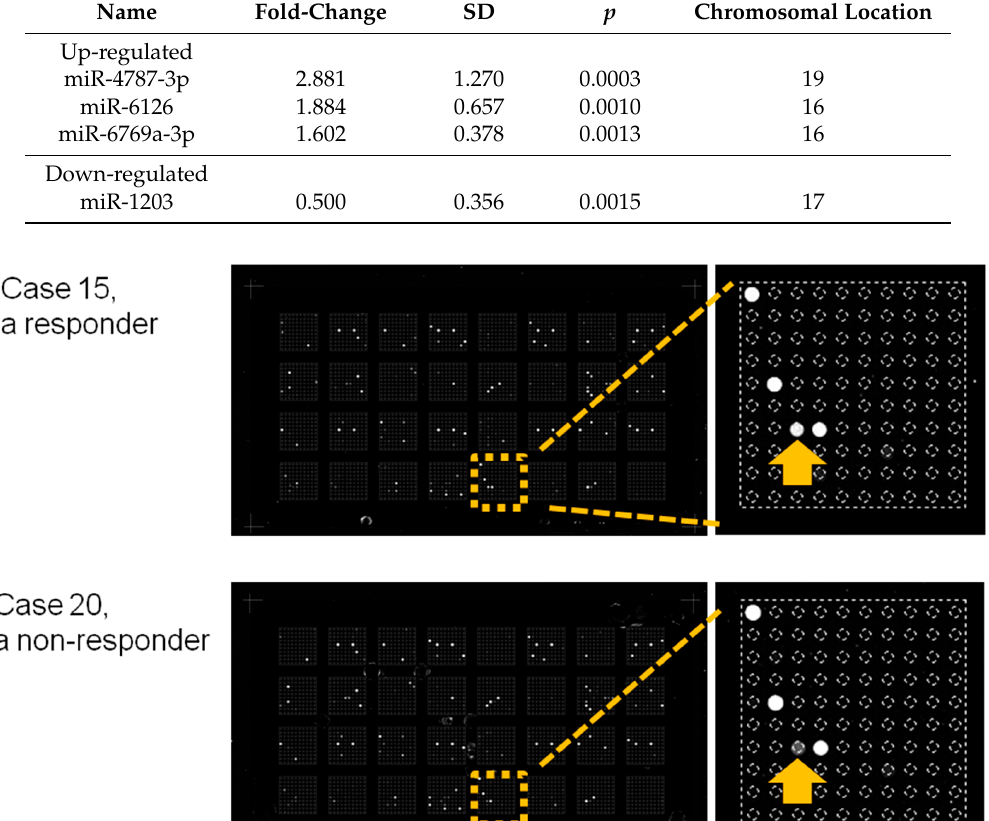
Table 2. Serum miRNAs at week 24 predicting HBsAg 1-log drop after the observation period relative to HBsAg levels at baseline.